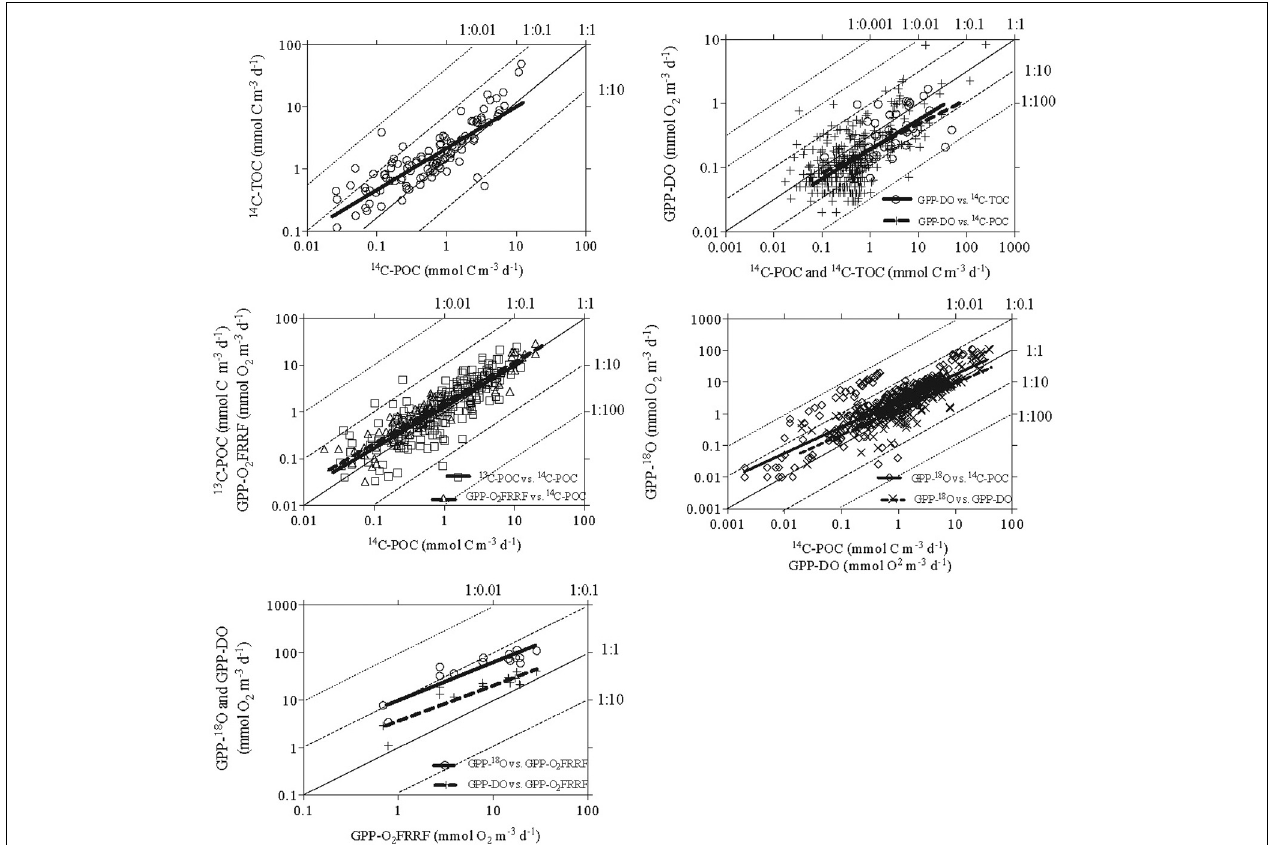
FIGURE 3 | Relationships between the log-log transformed primary production rates measured by different methods concurrently. The bold solid lines represent the linear regressions, the thin solid lines